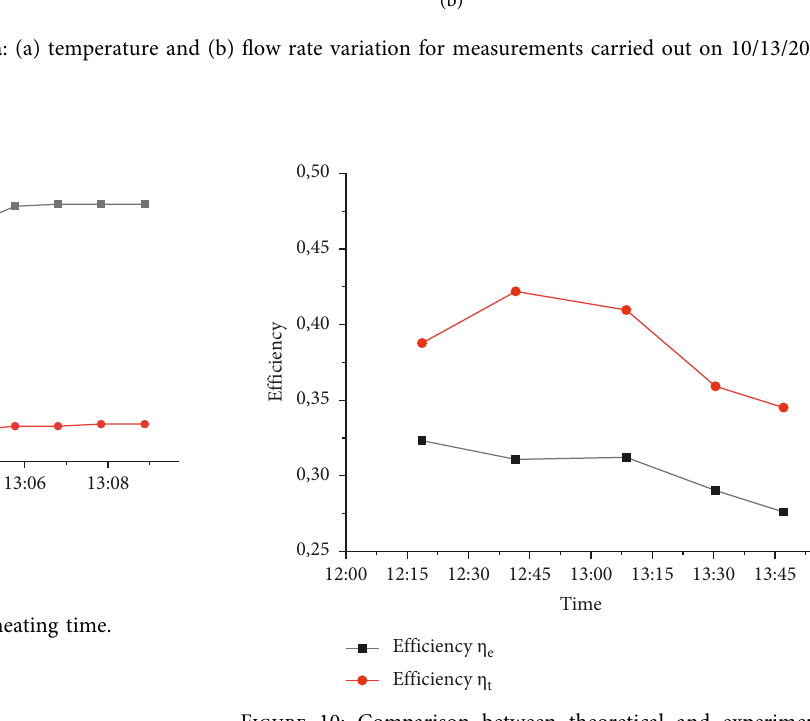
Figure 10: Comparison between theoretical and experimental efficiency.